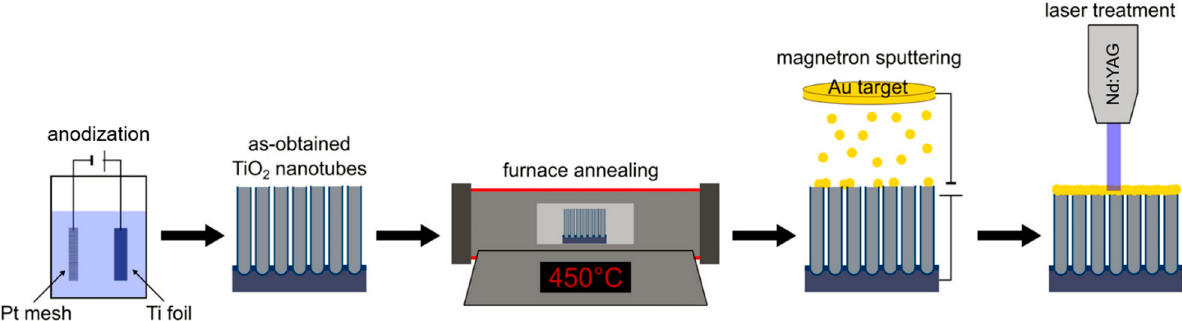
Figure 1. Illustration of protocol to obtain laser-modified TiO 2 NTs, based on Au-decorated TiO 2 NTs. Reprinted with permission from [45]. Copyright (2022) Creative Commons Attribution. Reprinted with permission from [45]. Copyright (2022) Creative Commons